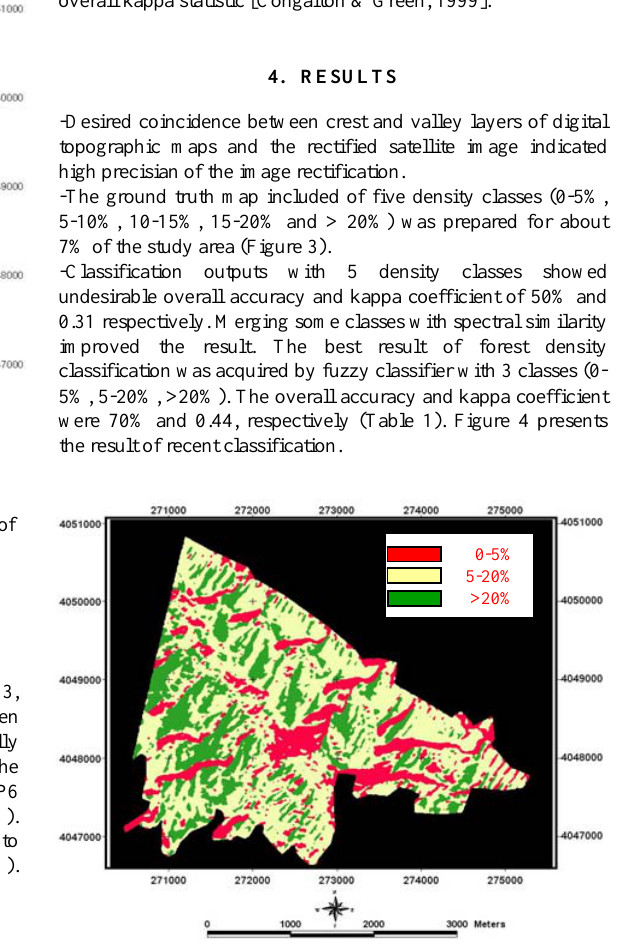
Figure 4. Map of canopy density with three classes resulted from fuzzy classifier ( UTM Zone 41, WGS84